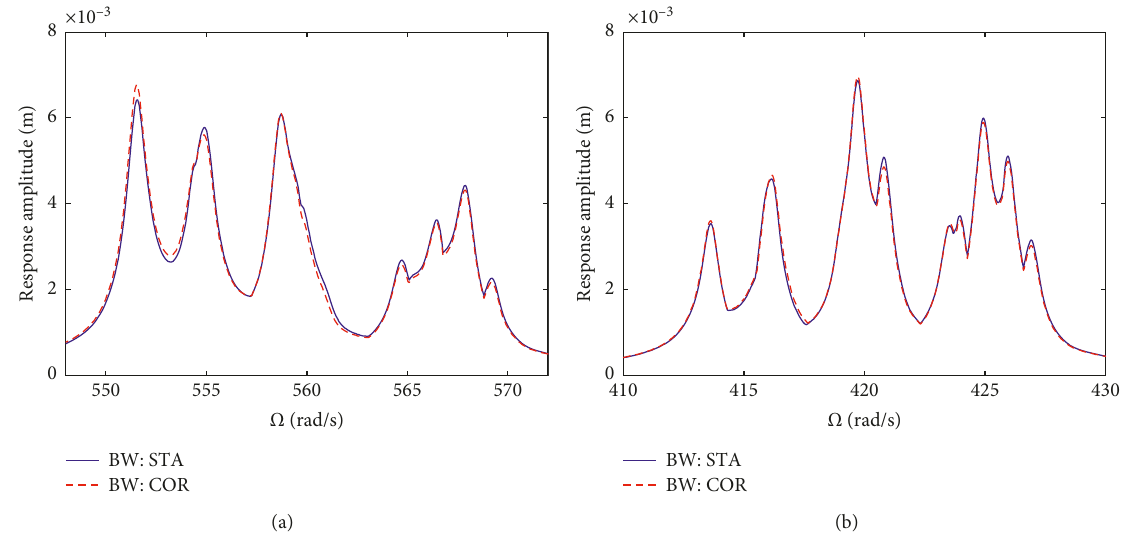
Figure 8: Forced response of mistuned bladed disk with and without considering the Coriolis forces excited by backward traveling wave excitations of (a) 3EO and (b)